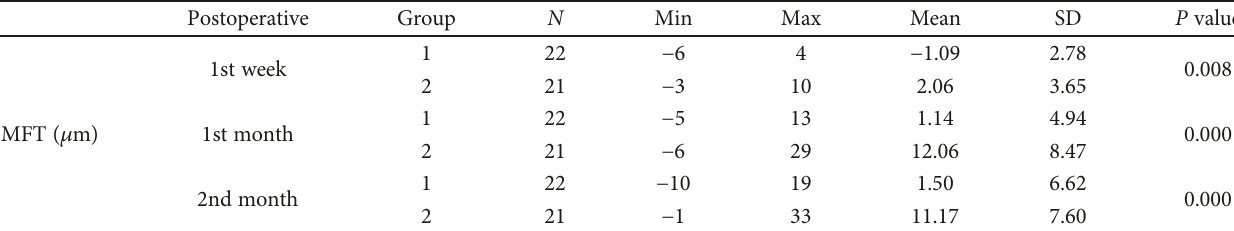
Table 3: Postoperative changes in mean foveal thickness.